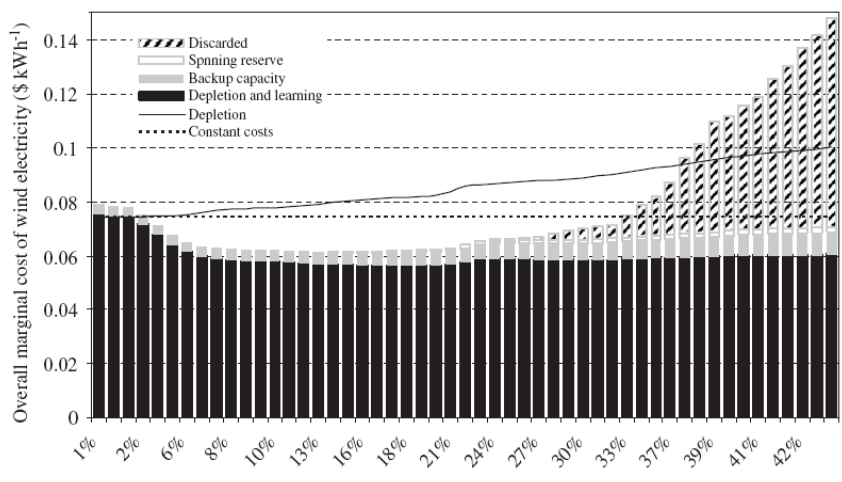
Figure 54. Marginal cost of wind electricity at varying degrees of penetration [191,204]. © 2007 Elsevier, reproduced with